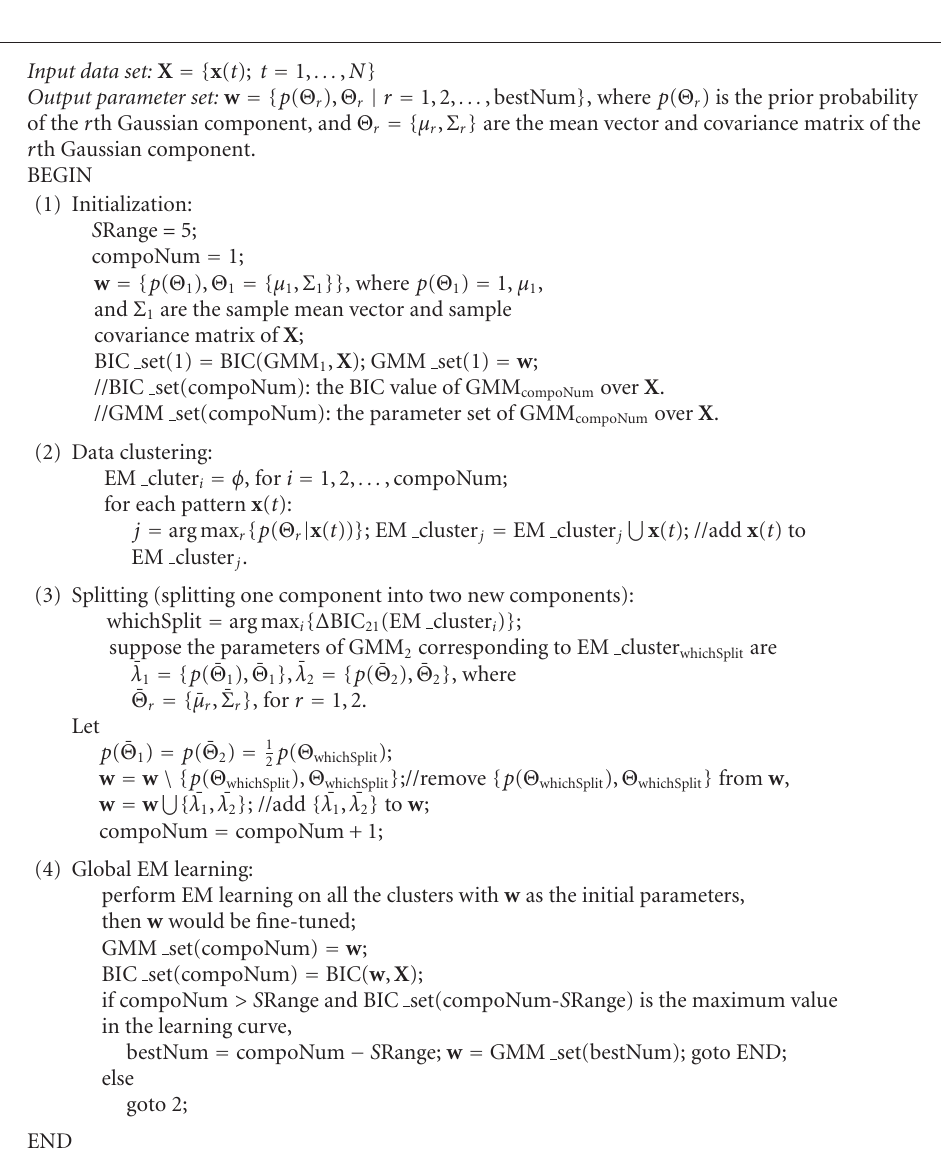
Algorithm 1: The SGML